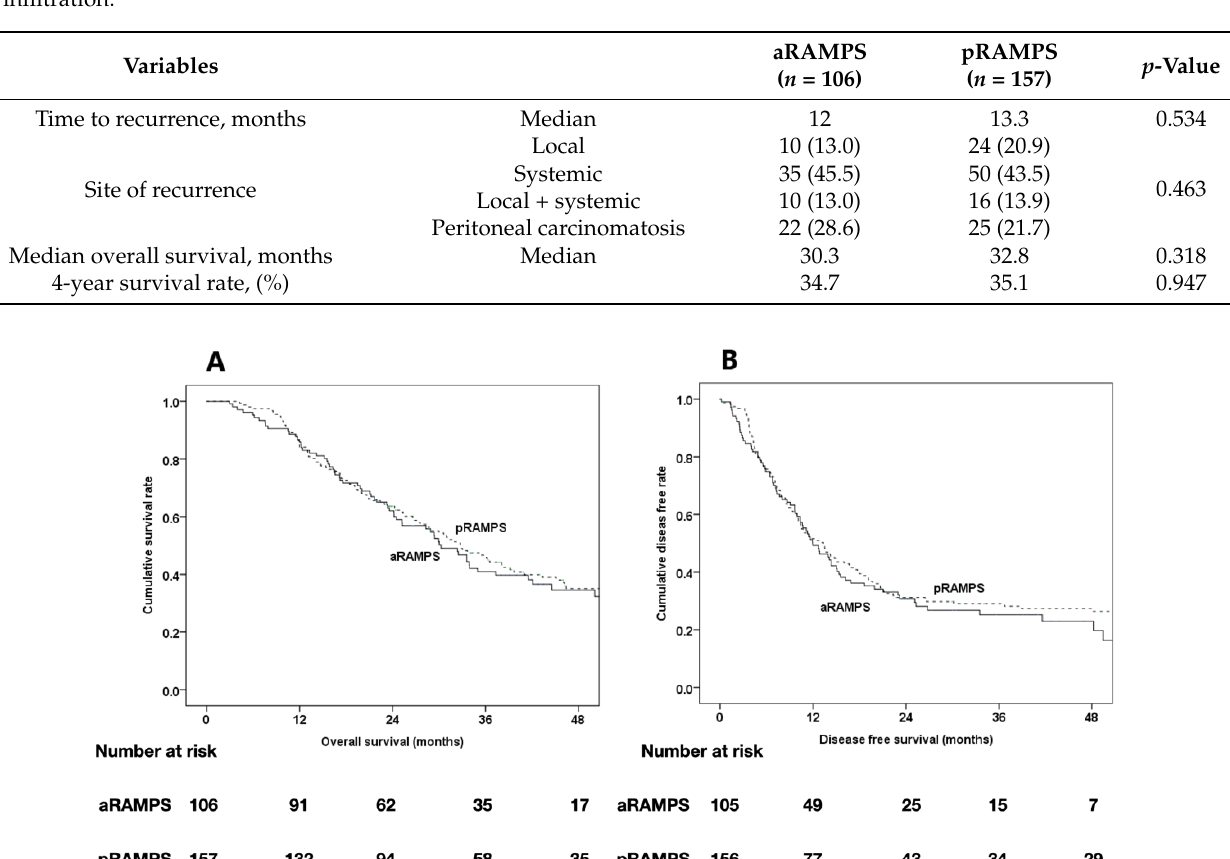
Figure 2. Kaplan–Meier survival curves of the cases in the aRAMPS group ( n = 106) and the pRAMPS group ( n = 157) without adrenal gland infiltration. ( A ) The median overall survival (OS) and estimated 1-, 2-, and 4-year OS rates were 30.3 months and 85.8%, 62.1%, and 34.7%, respectively, in the aRAMPS group and 32.8 months and 84.1%, 63.6%, and 35.1%, respectively, in the pRAMPS group ( p = 0.318). ( B ) The median disease-free survival (DFS) and estimated 1-, 2-, and 4-year DFS rates were 12.0 months and 49.3%, 30.8%, and 22.9%, respectively, in the aRAMPS group and 13.3 months and 51.6%, 31.2%, and 27.3%, respectively, in the pRAMPS group ( p =